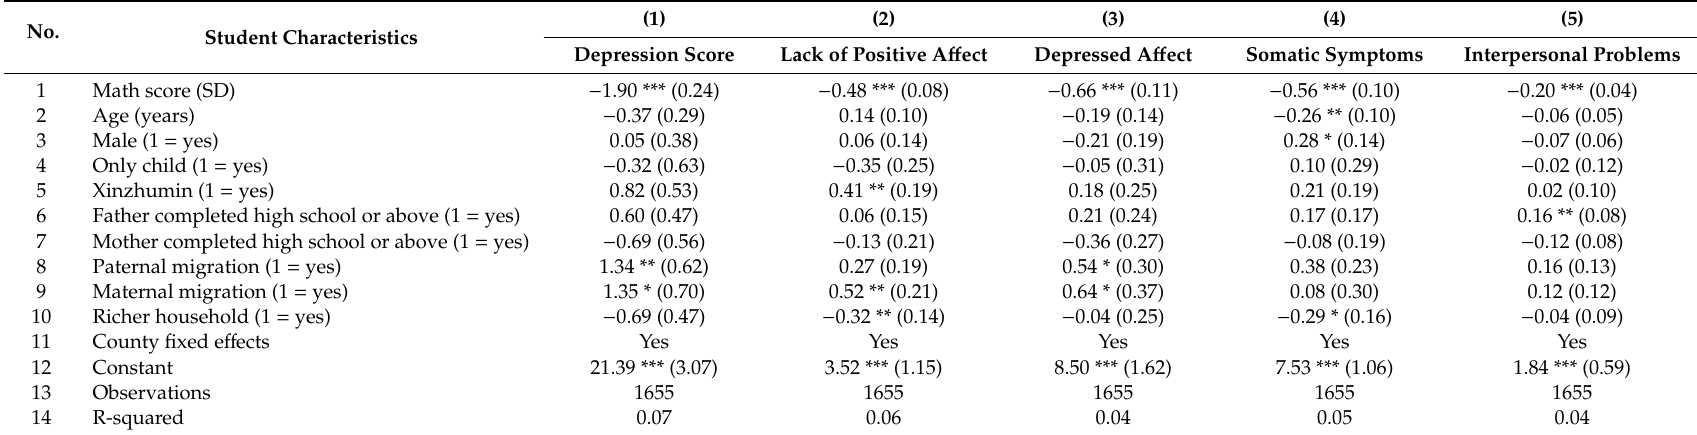
Table 3. Ordinary least square (OLS) regression on correlation between depressive symptoms and academic performance across di ff erent factors.